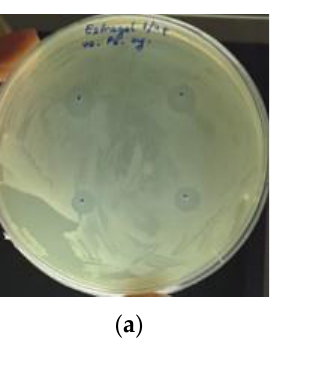
Figure 3. Pseudomonas syringae cultures grown in the presence of linalool (after 3 days), in different concentrations. ( a ) C 1 = 25%; ( b ) C 2 = 50%; ( c ) C 3 = 100%.